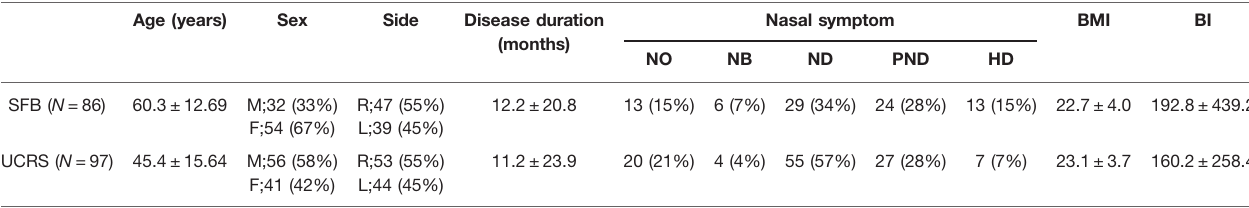
TABLE 1 | Demographic information of the patients with SFB and UCRS ( N